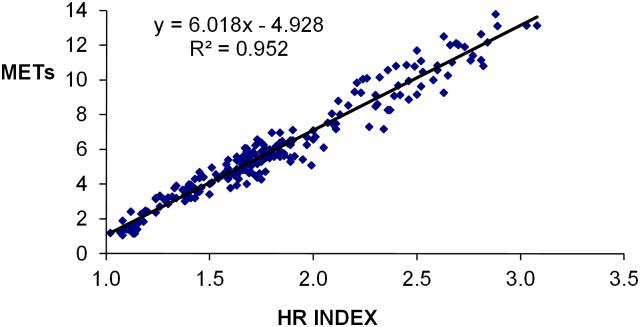
Linear regression plot of HR index equation.An analysis from data (n = 220) derived from 60 studies with the HR index equation simplified to METs = 6 x HR index– 5.